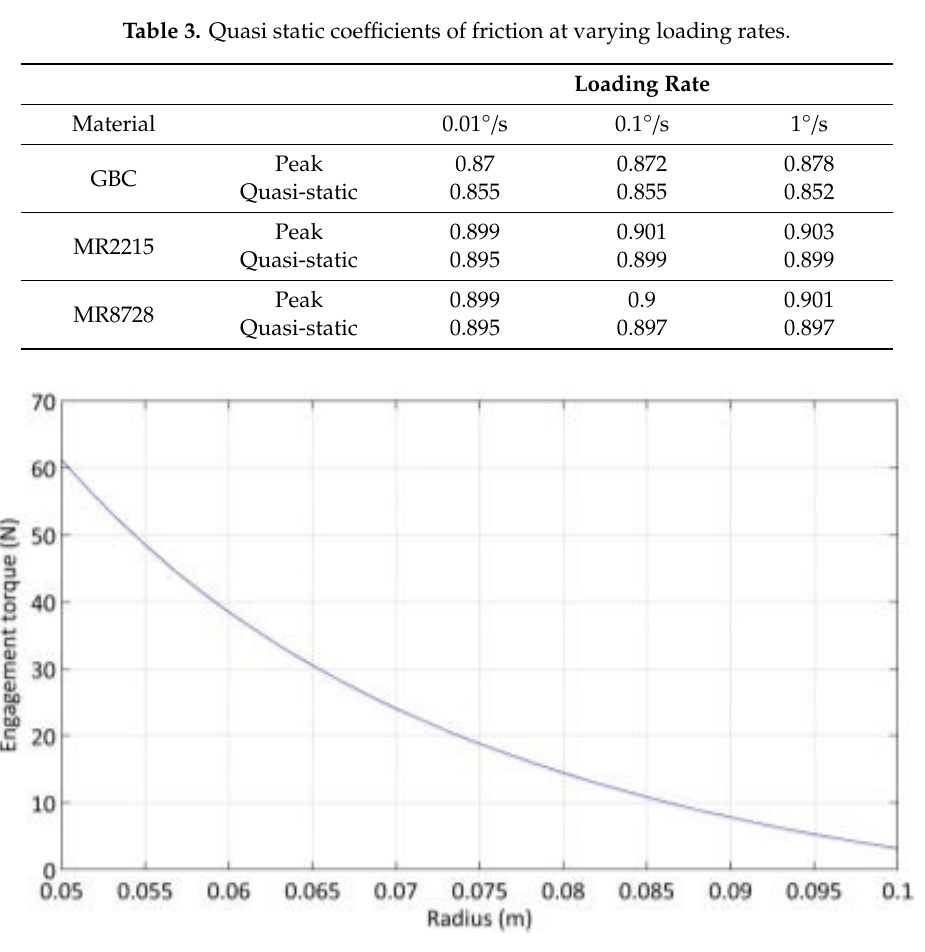
Figure 13. Engagement torque versus shaft radius (coefficient of friction = 0.9).